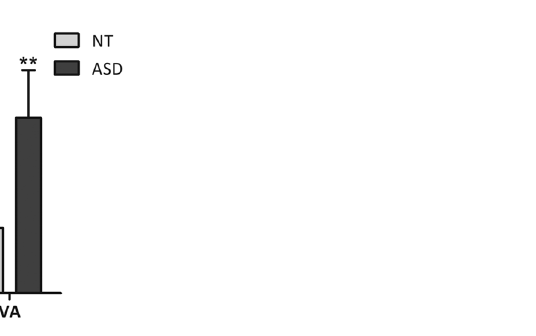
Figure 1. Fecal levels of short-chain fatty acids in participants. AA: acetic acid, PPA: propionic acid, BTA: butyrate, VA: valeric acid. Values are expressed as the mean ± SD, * p < 0.05 vs NT group; ** p < 0.01 vs NT group. Constipation alters the composition of the gut microbiota in ASD.